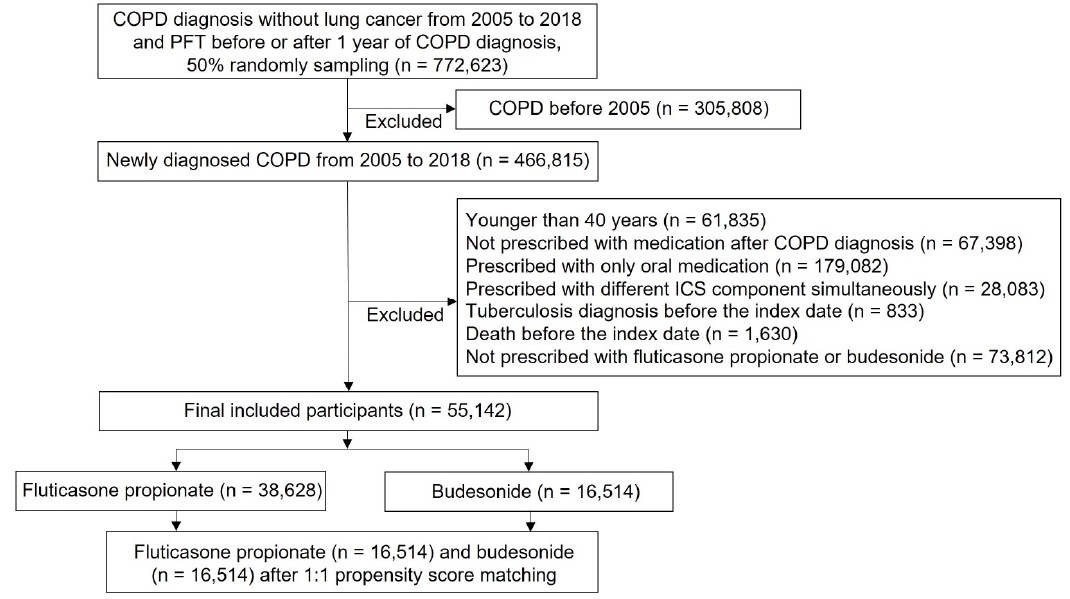
Figure 1. Flowchart of patient selection. Table 1. Baseline characteristics of the study participants.